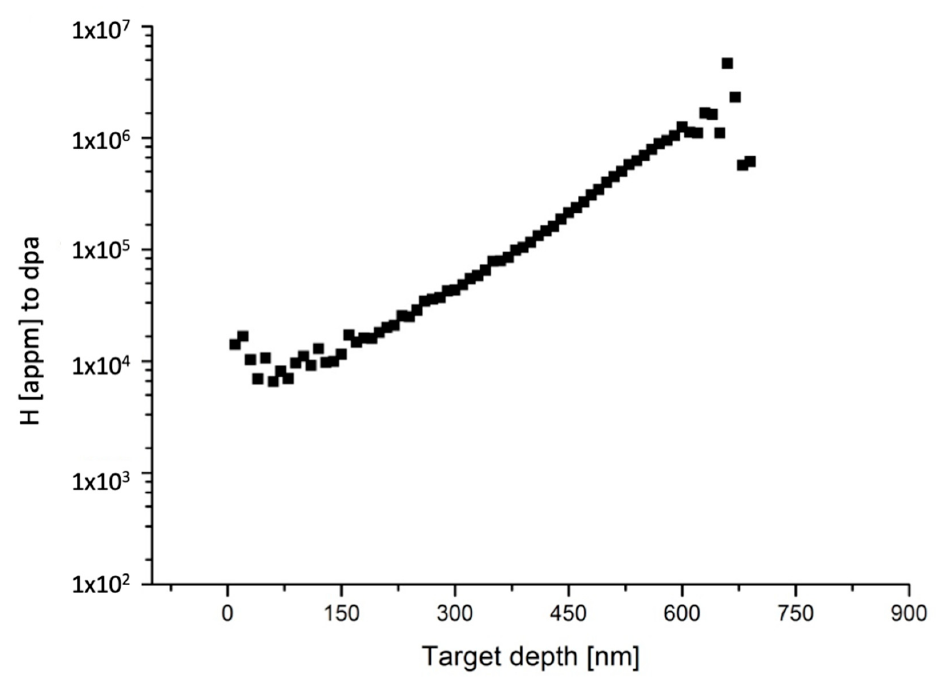
Figure 6. H/dpa ratio as the function of depth. Figure 6. H / dpa ratio as the function of